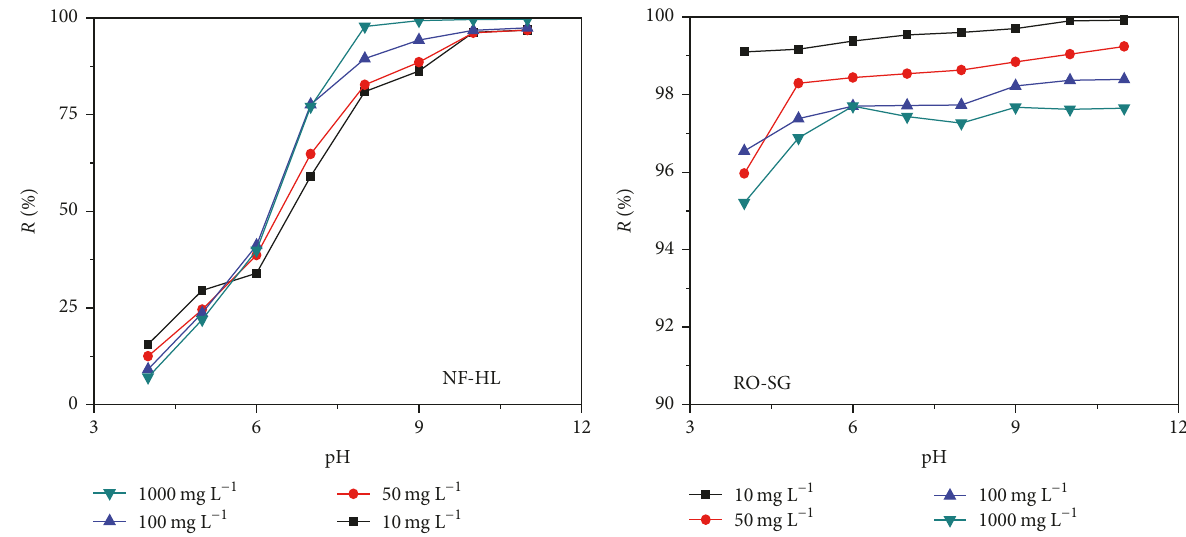
Figure 3: Evolution of retention rate of Cr(VI) as a function of initial feed concentration at different